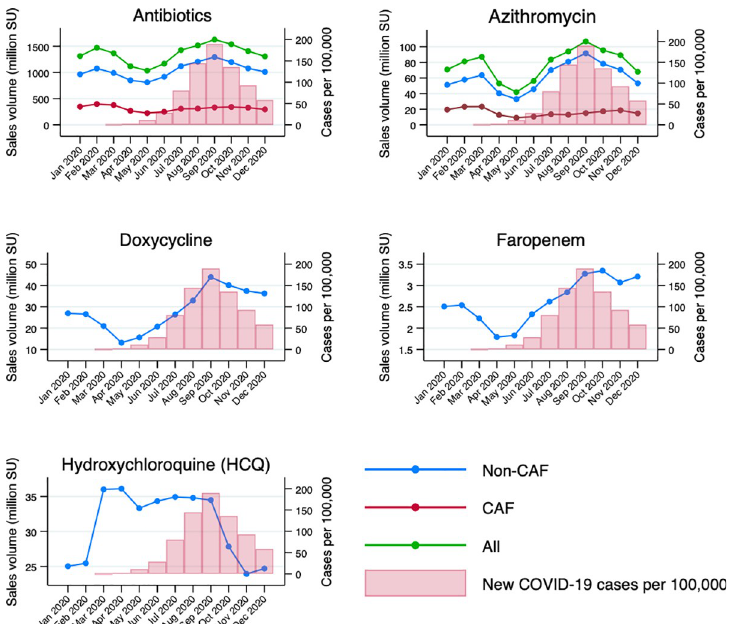
Fig 2. Relationship between new COVID-19 cases per 100,000 (cumulative rate per month) and national sales volumes of antibiotics, azithromycin, doxycycline, faropenem, and HCQ from January to December 2020. CAF, non-CAF, and total sales are reported. Data on antibiotics are inclusive of azithromycin. HCQ and faropenem are only shown as non-CAFs because CAFs are not available for these drugs. As only a very small proportion of doxycycline is sold as CAF, this is omitted in the graph. CAF, child-appropriate formulation; HCQ, hydroxychloroquine, SU, standard unit.